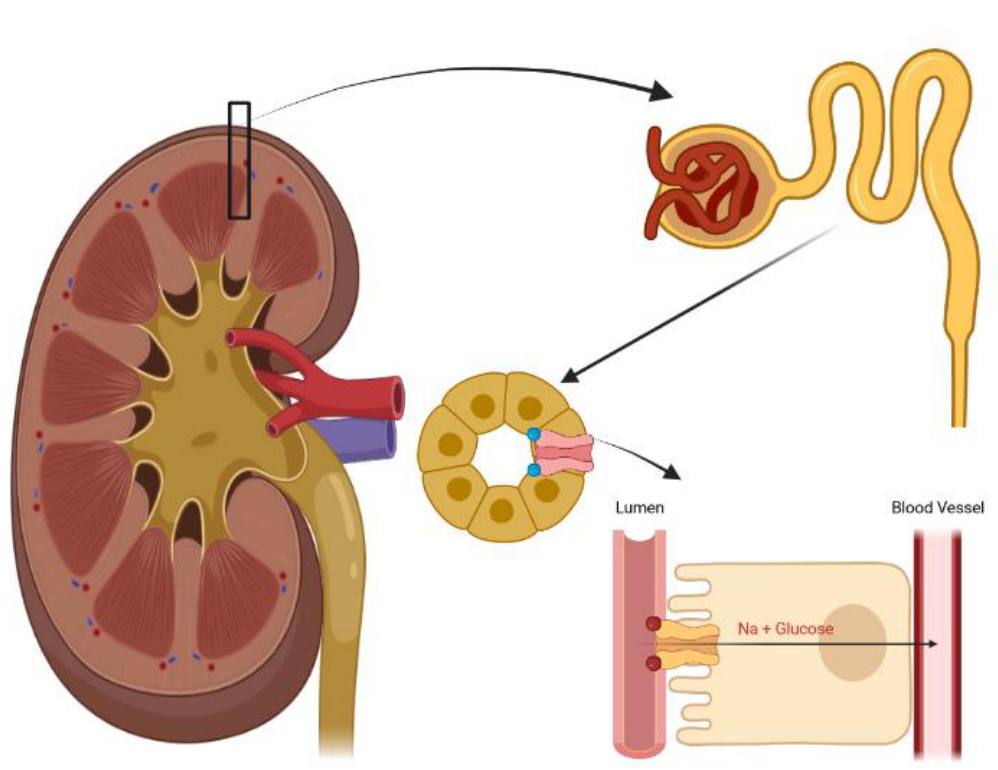
Figure 1: The mechanism of SGLT2 activity in the renal proximal tubule. SGLT2 inhibitors inhibit SGLT2 activity and induce urinary glucose and sodium